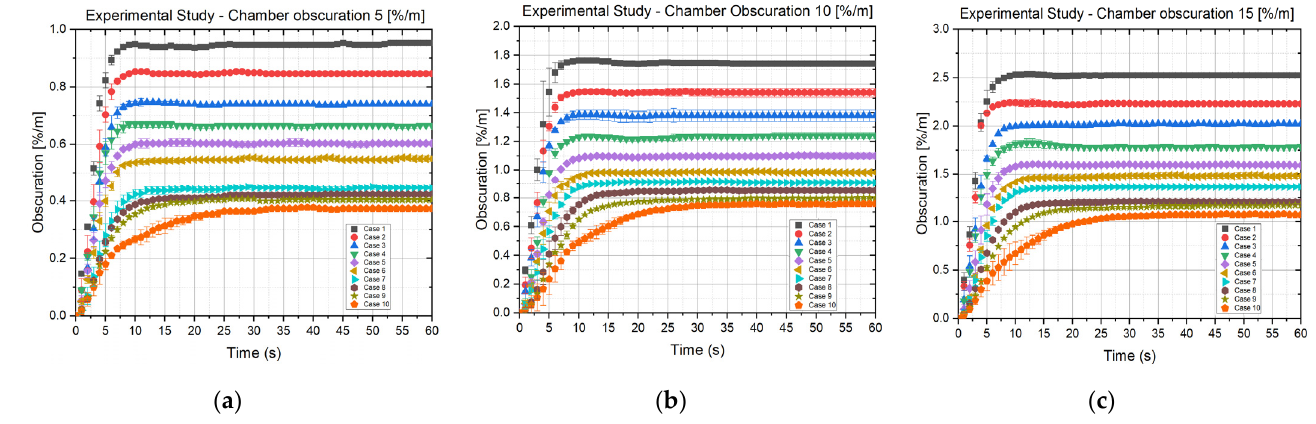
Figure 5. The obscuration at ASD ( a ) The obscuration at ASD when chamber obscuration was 5%/m ( b ) The obscuration at ASD when chamber obscuration was 10%/m ( c ) When chamber obscuration was 15%/m.